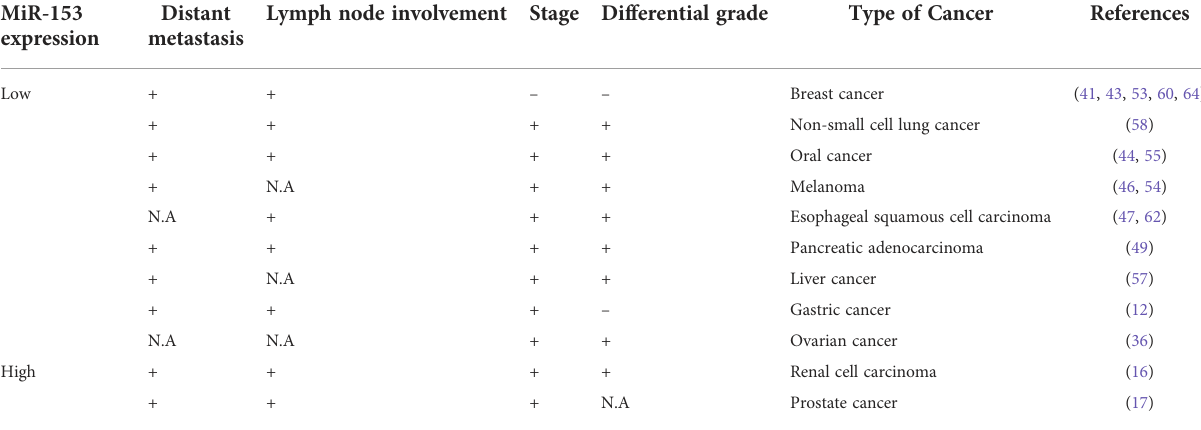
TABLE 4 Low or high expression level of miRNA-153 is associated with the prognostic parameters in different types of cancer. MiR-153